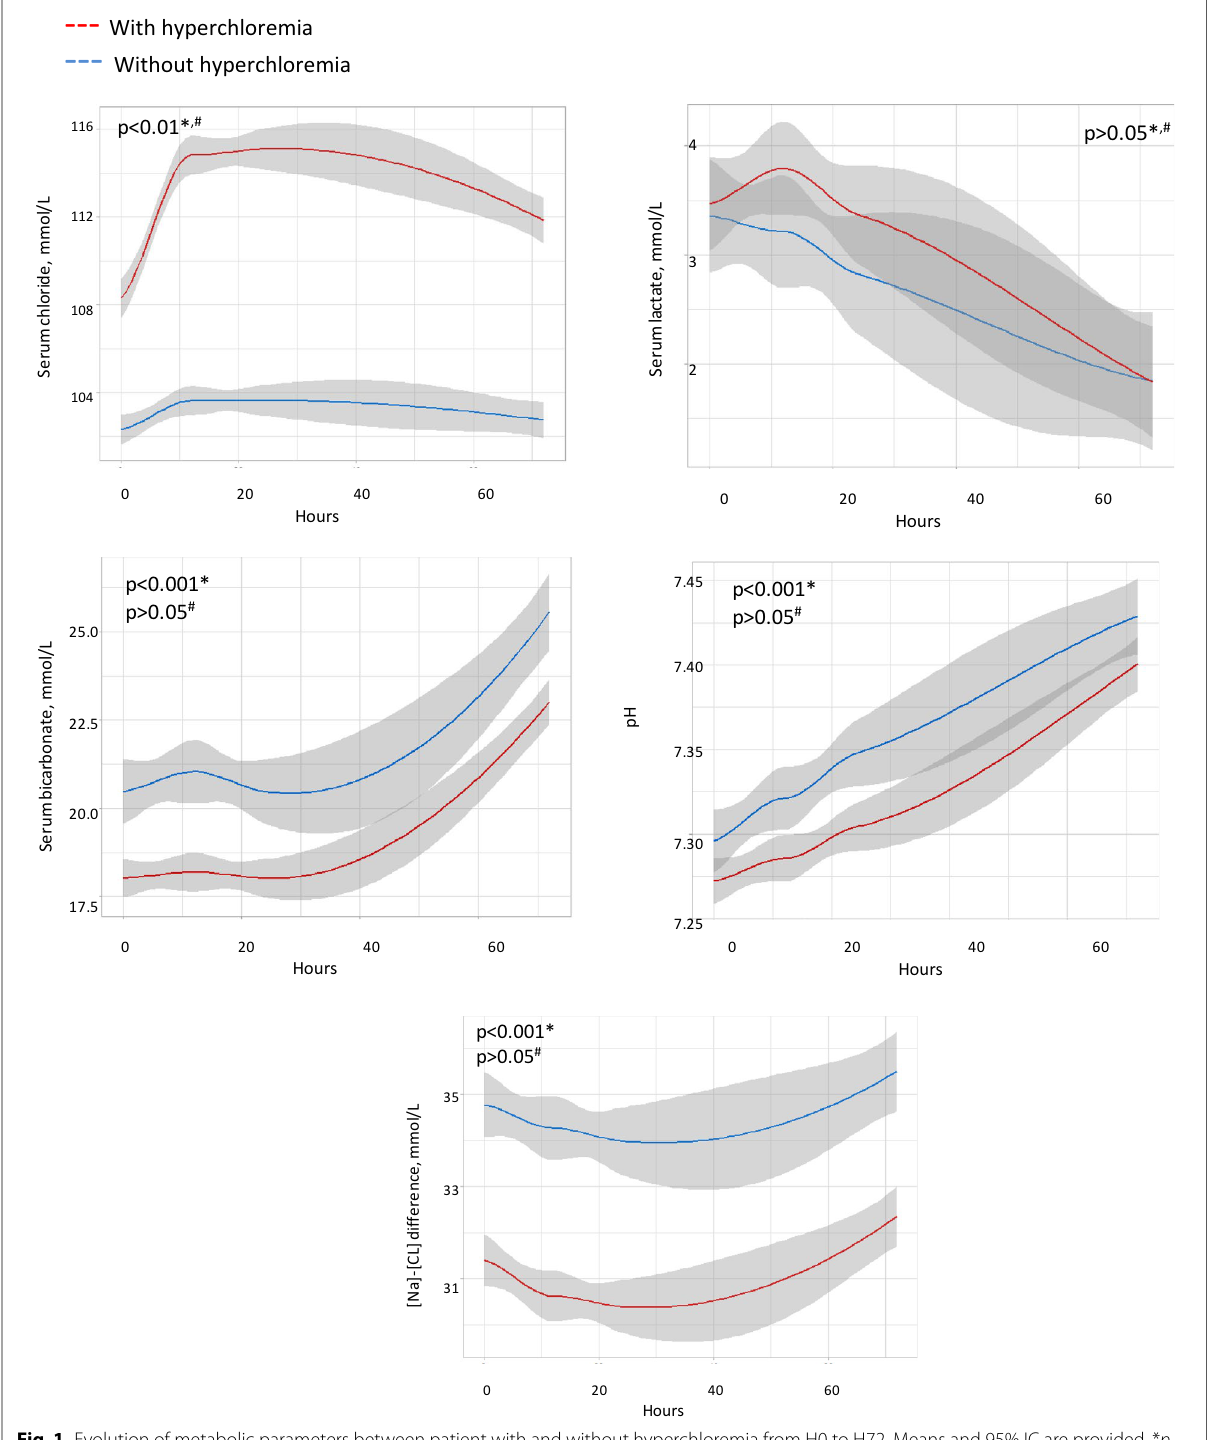
Fig. 1 Evolution of metabolic parameters between patient with and without hyperchloremia from H0 to H72. Means and 95% IC are provided. * p value for comparison at H0. # p value for comparison of the evolution over time (results of Generalized Linear Mixed Model for pH and Generalized Non-Linear Mixed Model for